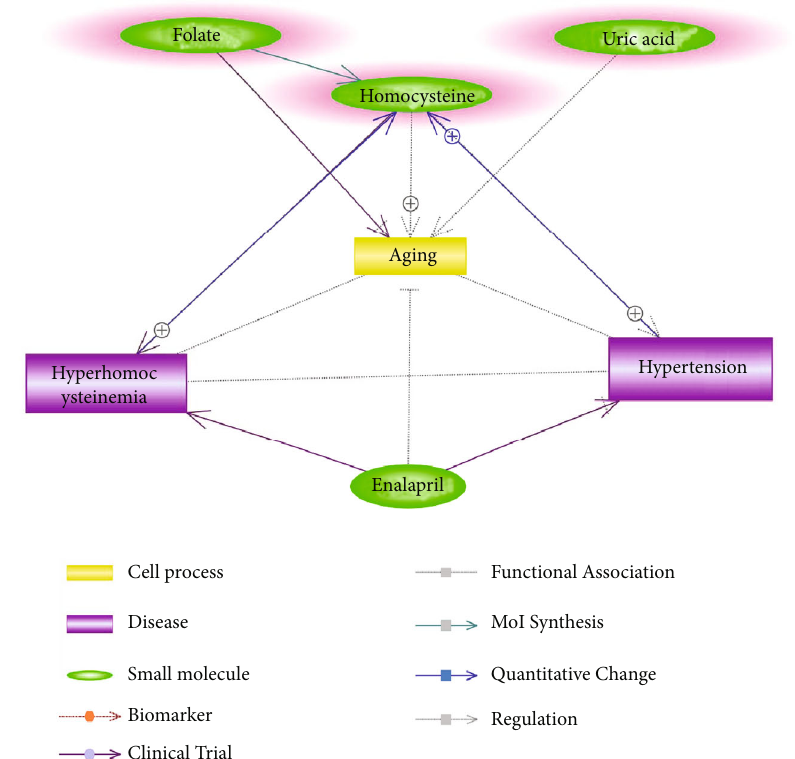
Figure 2: Pathway showing the role of aging in H-type hypertension and its treatment using enalapril maleate and folic acid